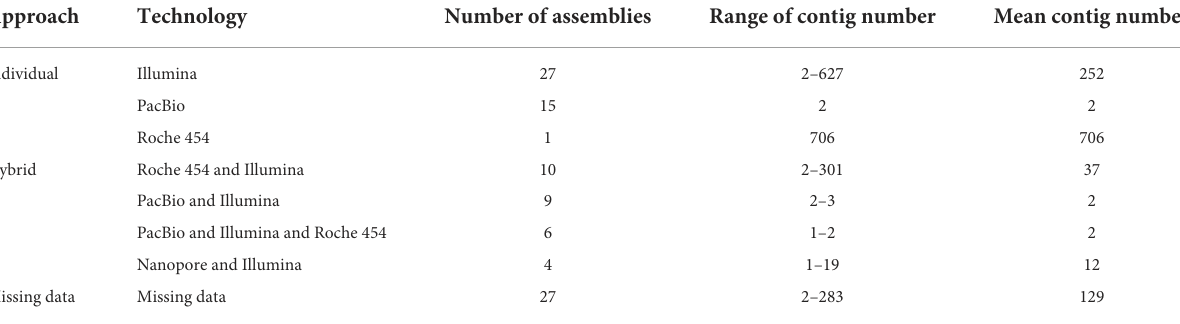
TABLE 2 Overview of the recent status of B. mallei sequencing data deposited in the NCBI RefSeq public repository since 2004. Approach Number of assemblies Range of contig